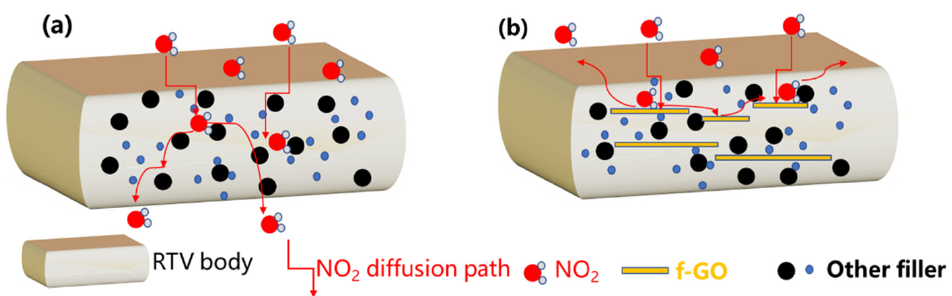
Figure 12. The physical barrier mechanism diagram of RTV ( a ) and f-GO/RTV ( b ).